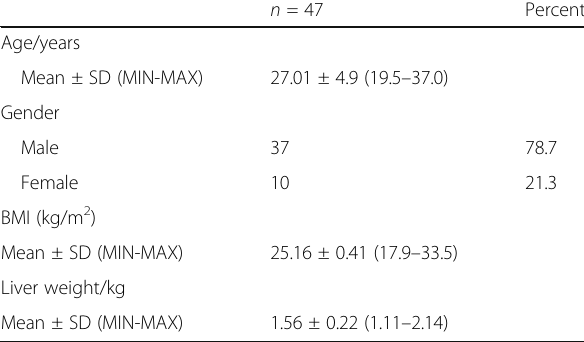
Table 1 Demographic and clinical criteria of studied